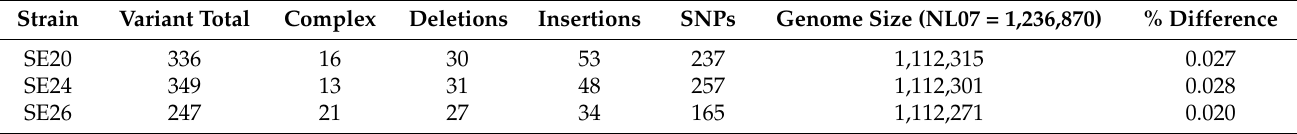
Table 2. Genetic variation between NL07 and SE20 and SE24 and SE26. The Table shows the total amount of variants between NL07 and a given strain (Variant total), the number of multiple nucleotide polymorphisms (Complex), the number of deletions (Deletions), the number of insertions (Insertions), the number of single nucleotide polymorphisms (SNPs), the assembly size (Genome size), and the percentage in difference between NL07 and a given strain in the aligned regions (%